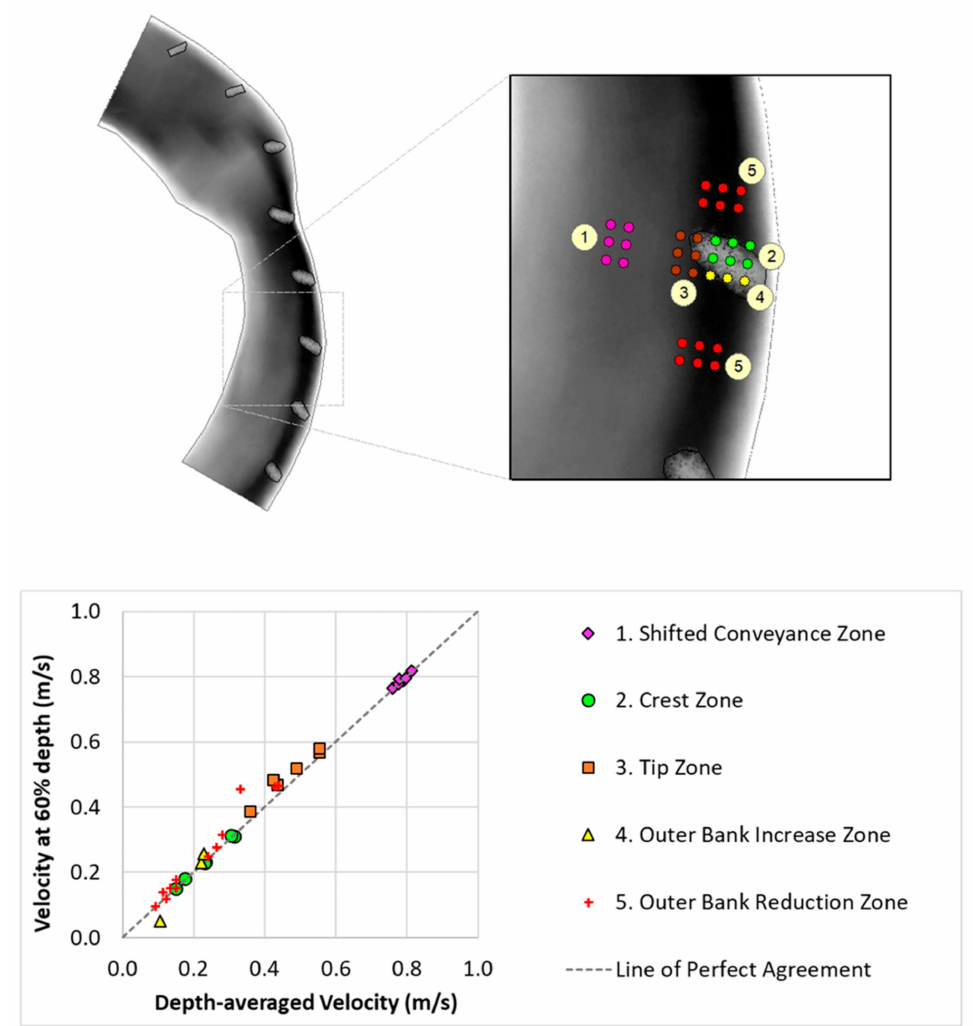
Figure 13. Point velocity (60% of depth from water surface) compared to the integrated depth average velocity using either 5% or 20% depth intervals for bendway weir configuration